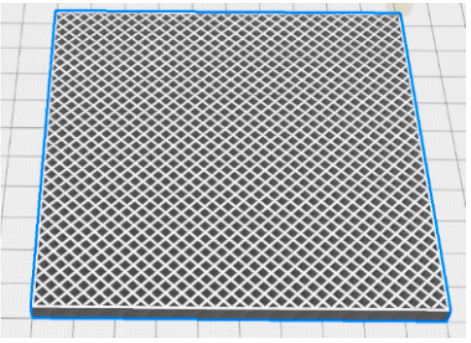
Figure 3. Image of a sample with the “Grid” pattern sliced in Ultimaker Cura, with an “infill line pattern” at 2.8 mm (1.8 mm for the size of the holes and 1 mm for the wall).